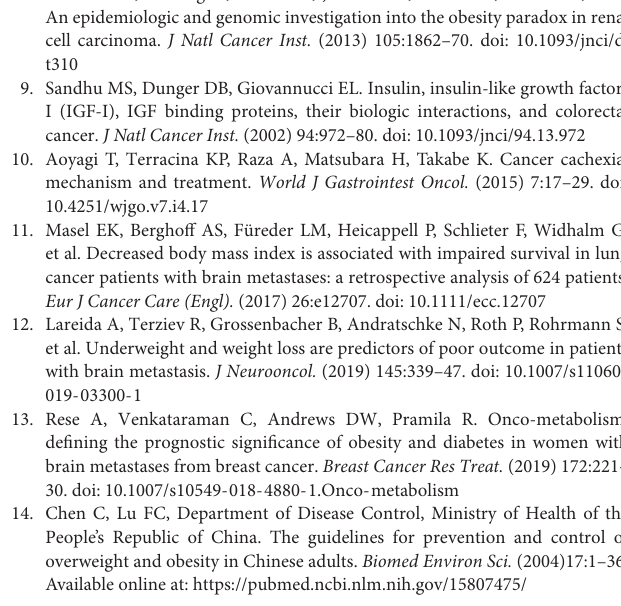
Assessment for brain metastases; BMI, body mass index (recorded when brain metastases was diagnosed). Supplementary Figure 2 | The modified-GPA model for brain metastasis prognosis by adding BMI information. BMI, body mass index (recorded when brain metastases was diagnosed); KPS, Karnofsky performance